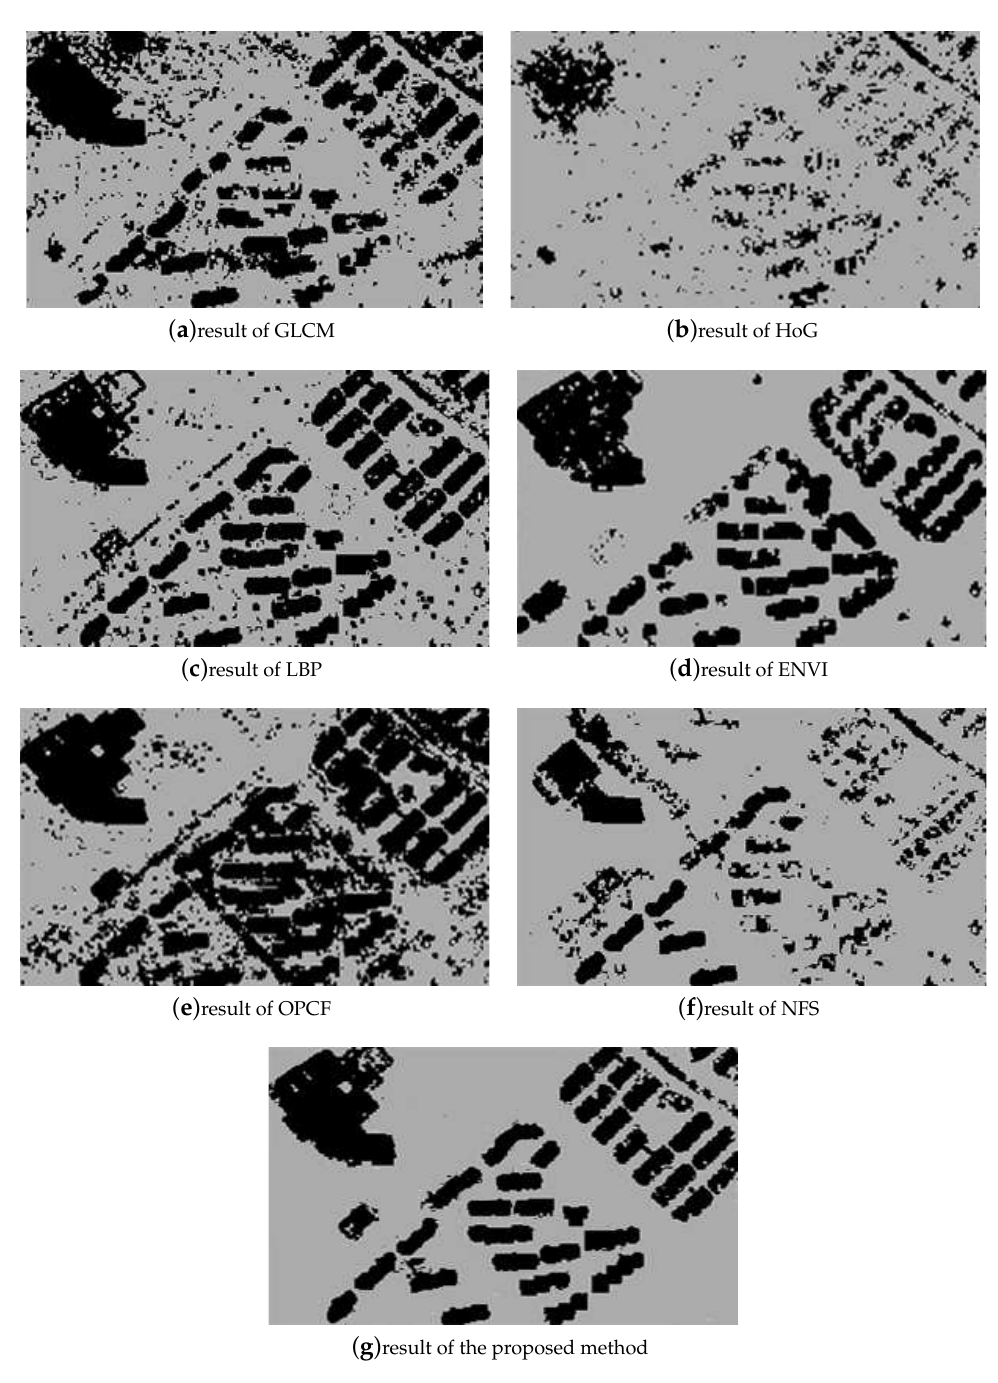
Figure 9. Building extraction results of LDR